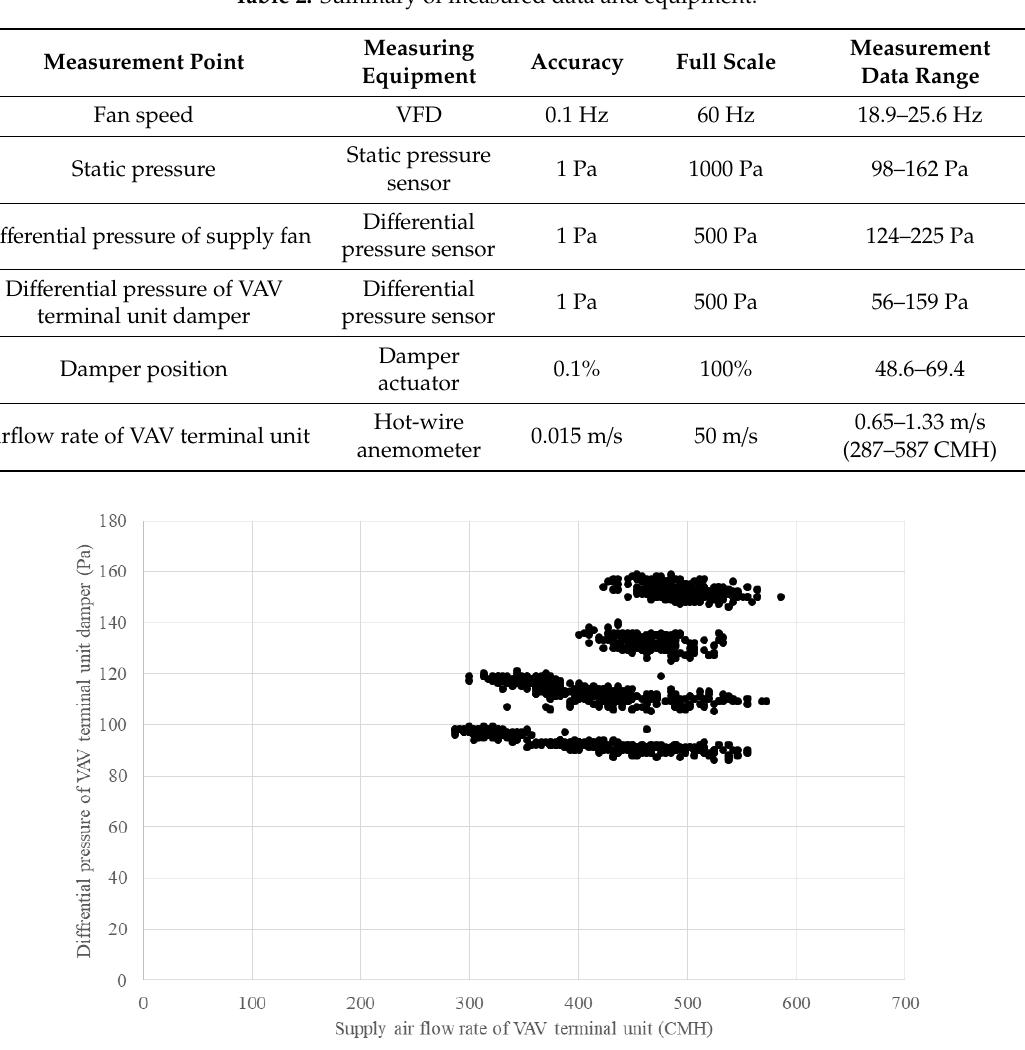
Figure 2. Relationship between differential pressure and airflow rate of variable air volume (VAV) terminal unit.